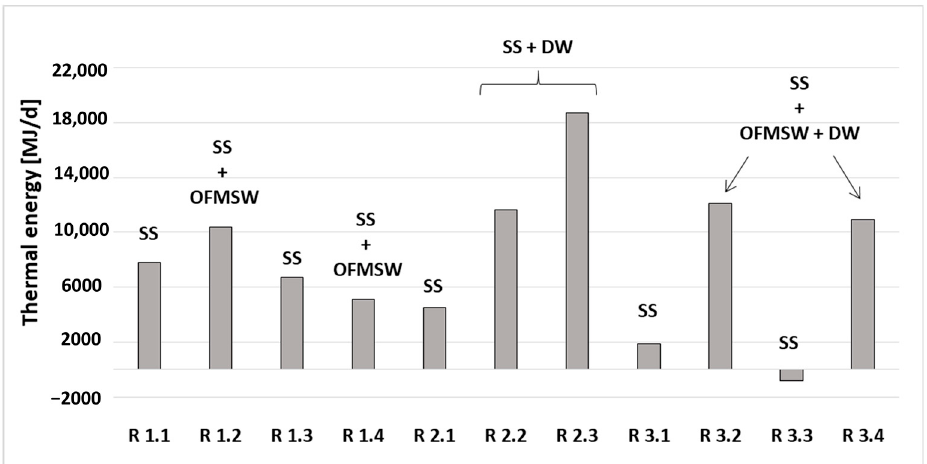
Figure 2. Profit of thermal energy in experiments.